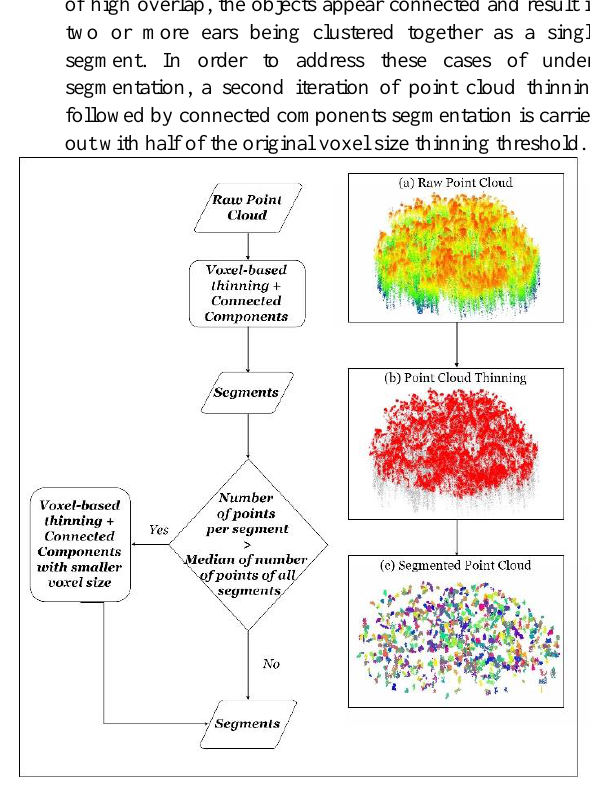
Figure 3 Flow-chart depicting the steps involved in the voxel- based connected components